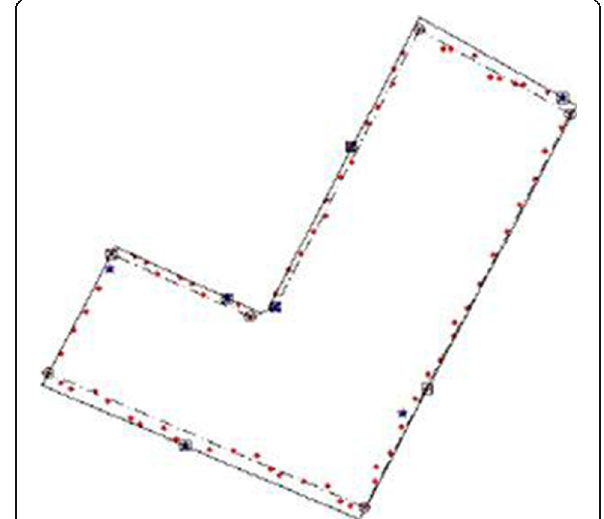
Figure 6 is a geometric relationship of the three adjacent